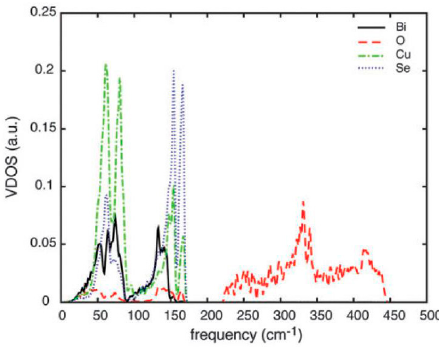
Figure 7. Total vibrational DOS of BiCuSeO projected on each element (Bi, Cu, Se, O). Reproduced with permission from Reference [48]. Copyright 2015, The American Royal Society of Chemitry.